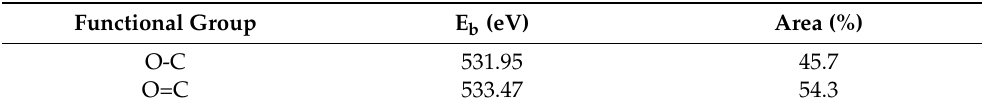
Table 3. The surface functional group content of oxygen element (O) of water-insoluble gardenia blue pigment.